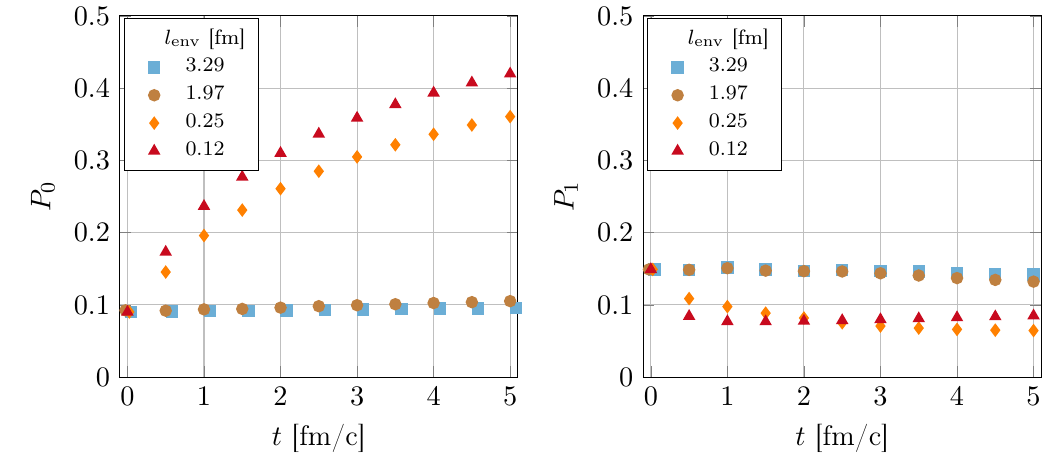
Figure 5 . On the left (right): probability of having the ground (excited) state at time t for di(cid:11)erent correlation lengths of the environment, starting o(cid:11) with an initial density matrix corresponding to a thermal scattering state ( (cid:14) = 2 : 5 fm and p = 0 : 69 GeV). Recall that the typical sizes of the (cid:0) p p p quantum states are x 2 = 0 : 162 fm, x 2 = 0 : 384 fm and x 2 = (cid:14)= p 2 = 1 : 77 fm. h i 0 h i 1 h i scatt Some of the points are slightly shifted horizontally to avoid superpositions of